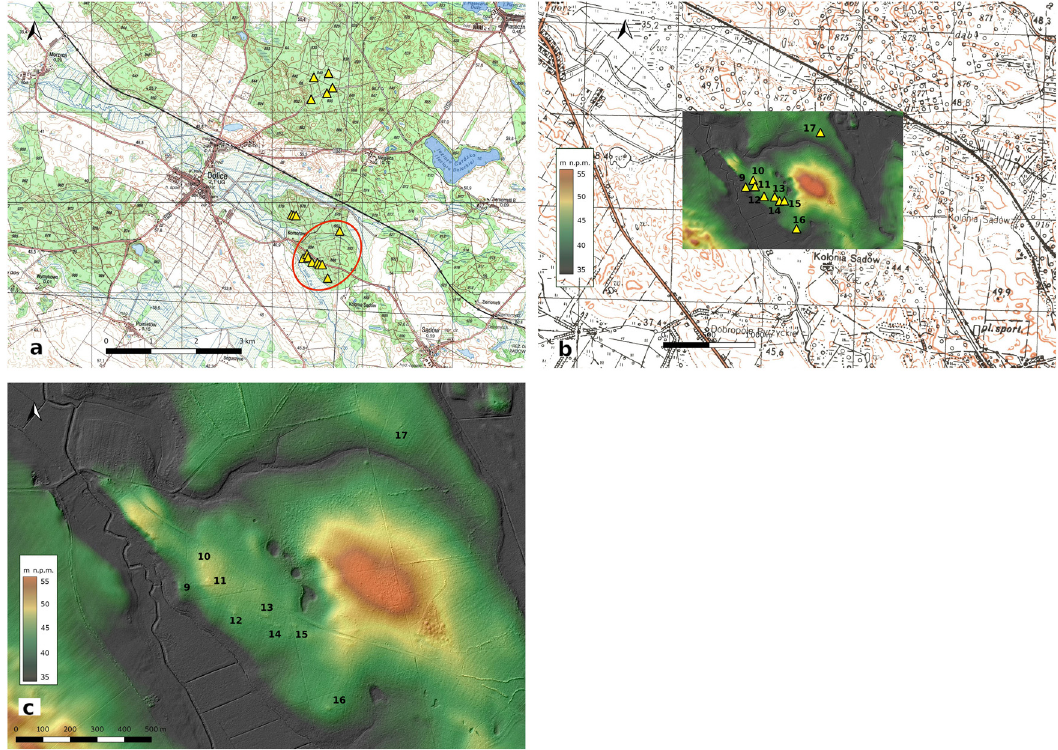
Figure 15: The Dolice - Komorowo South megalithic group shown among other groups of megalithic tombs in the Dolice mega - lithic group ( a ) , the group presented on a hypsometric map fragment ( b ) and its digital terrain model in hypsometric colours ( c ) ( M. Schiller )